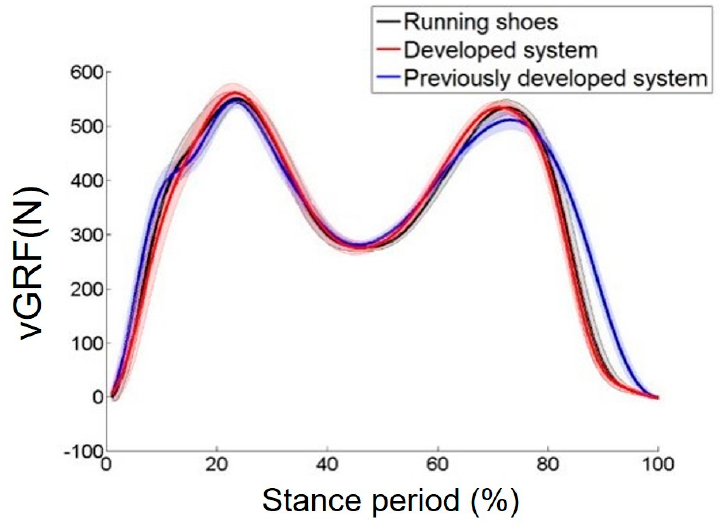
Figure 8. GRF measurement wearing the developed GRF measurement system, previously developed outsole GRF measurement system, and commercial running shoes (Z-Rated, Reebok, Boston, MA,